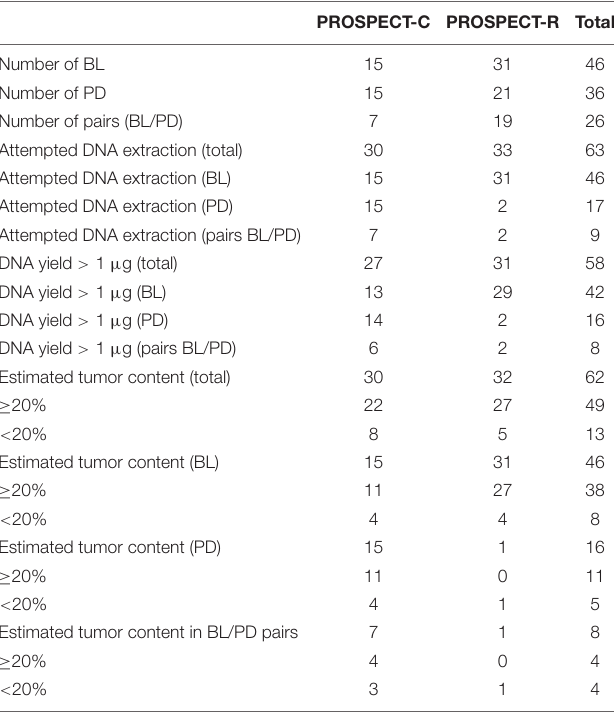
TABLE 1 | DNA extraction and estimated tumor content.